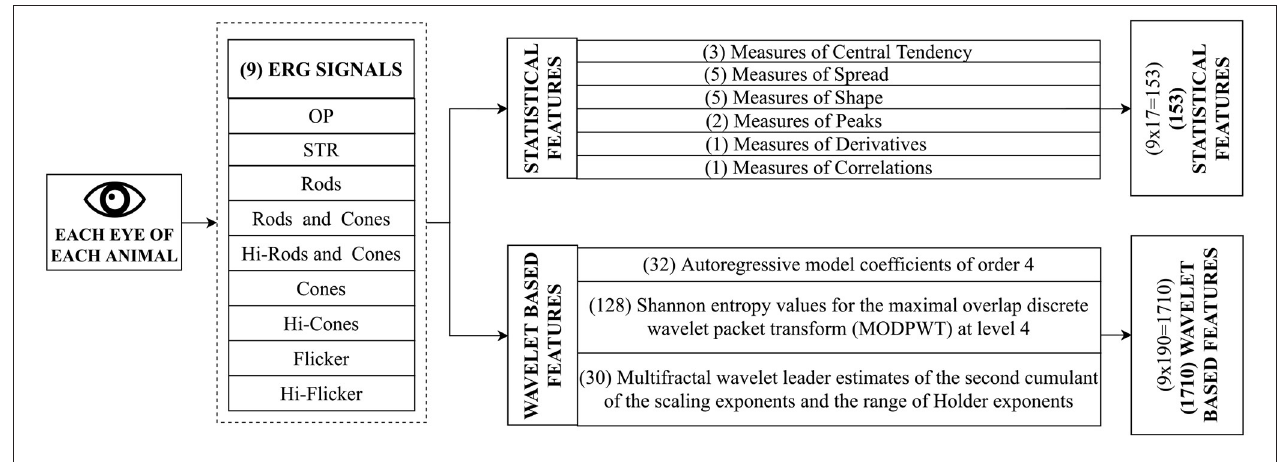
FIGURE 3 | Feature Extraction. During this process, mathematical operations are performed on the data to extract features. This step is crucial for discovering features indicative of functional deficits in the eye. ERG test on each eye leads to nine signals, as shown in Figure 2 . Two sets of features (Standard features and advanced features) are extracted from each of the nine signals. The standard set of features include common statistical features such as mean, quartiles, and entropies. In contrast, the advanced set of features include sophisticated features such as autoregressive coefficients, Shannon entropy, and wavelet